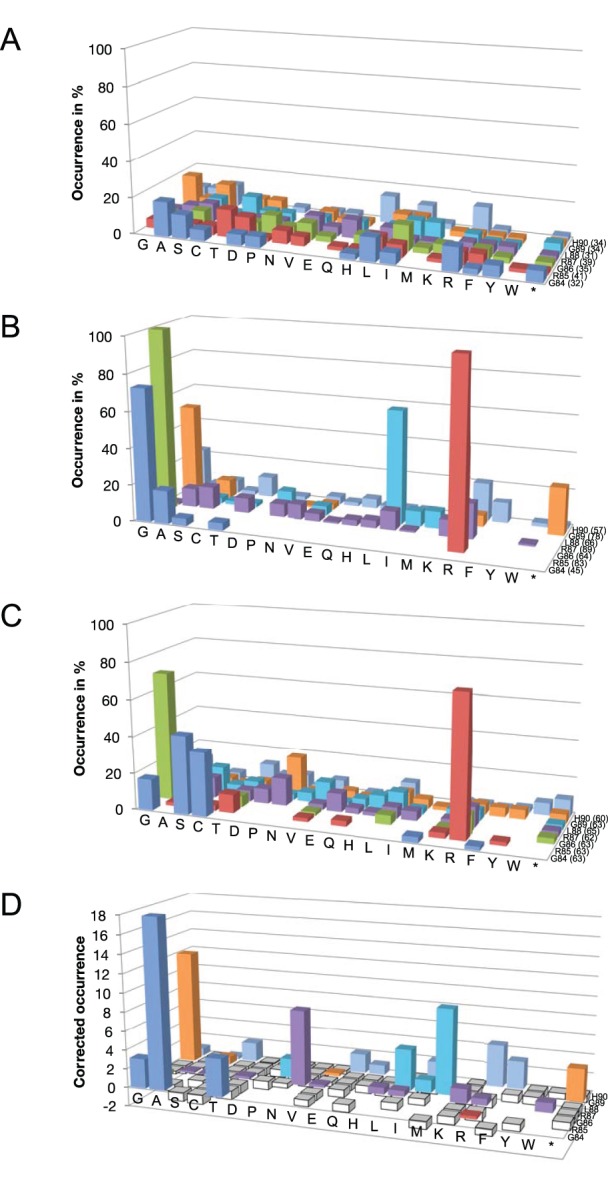
Amino acid distribution patterns in MtCM variants before and after selection experiments.Column colors correspond to the randomized positions 84 (blue), 85 (red), 86 (green), 87 (purple), 88 (cyan), 89 (orange), and 90 (light blue). Side chains are ordered according to increasing volume [48]; an asterisk denotes a stop codon. The absolute number of codons compiled at each position is indicated in parentheses next to the wild-type residue. The absolute numbers of individual residues found at every position are, in addition to the graphical representation of the relative frequencies shown here, listed in S1 Table. (A) Amino acid residues found under non-selective conditions (M9c +FY). The percentages (and standard deviations σn-1) of the 4 individual nucleotides averaged over every randomized position were 25.9 (±7.3)%, 26.5 (±7.5)%, 21.6 (±6.3)%, and 26.0 (±6.0)% for A, C, G, and T, respectively, in the analyzed sample set. (B) Preferred residues selected under a stringent regime (M9c, no inducer added) in the presence of the complex partner MtDS (in KA12/pKIMP-ACG). (C) Residue patterns emerging in selected MtCM variants grown in the absence of MtDS under conditions where free wild-type MtCM can complement the CM deficiency (in KA12/pKIMP-UAUC, plated on M9c +F +Tet500 ng/mL). (D) Correlated amino acid distribution patterns. Positive values indicate a residue preference in the complexed MtCM, whereas negative values (columns in white) show residues frequently observed in functional free MtCM. To simplify the arbitrary graphical summary, and to avoid division by 0, the value at each position represents the ratio of [number of a particular amino acid found in complexed MtCMs +1]/[number of the same amino acid found in the free MtCMs +1] −1.